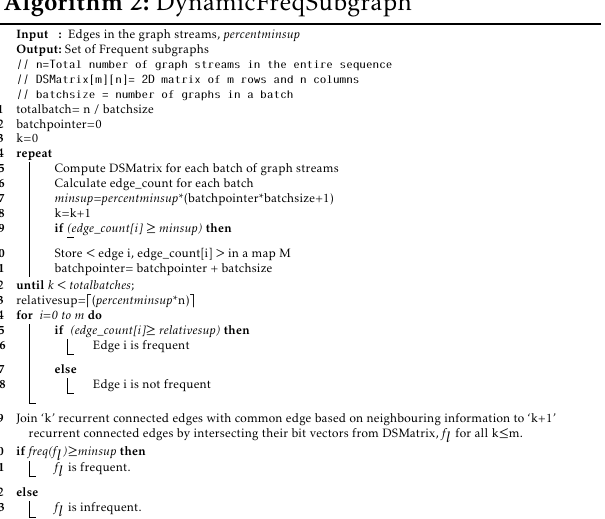
Algorithm 2: DynamicFreqSubgraph